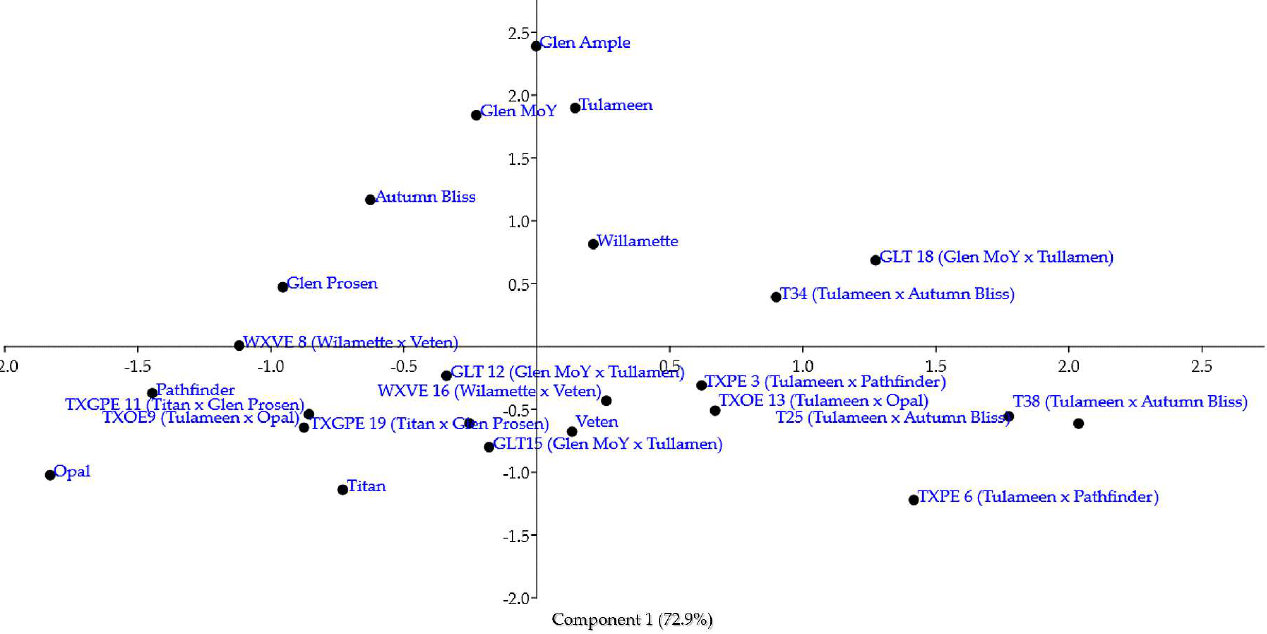
Figure 5. Hierarchical clustering analyses of the 24 raspberry genotypes (14 promising selections, their parents, and Glen Ample cultivar as control) based on 17 analyzed characteristics assessed via paired group UPGMA, the Gover similarity index. DM represents dry matter, TSS represents total soluble solids, and TA represents titratable acidity. Of the two largest clusters in the column dendrogram of genotypes, the one on the right is represented by only three descendant selections, of which the two that are placed